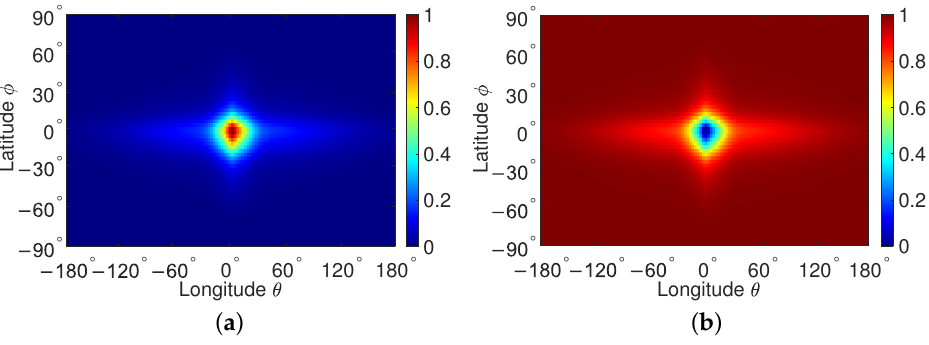
Figure 12. Normalized GMM for latitude and longitude: ( a ) Normalized relative viewing direction frequency ˆ u ( φ , θ ) , ( b ) Data hiding weight function w 3 ( φ , θ ) .